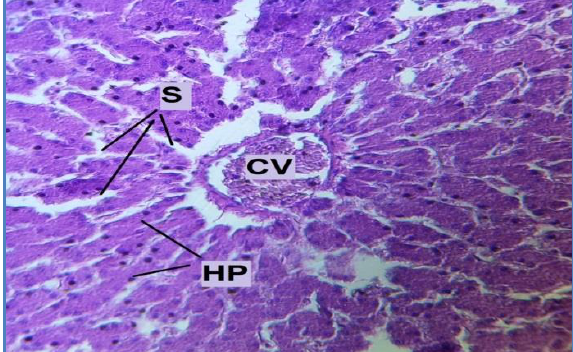
Figure, 7: Histological section of the liver in mallard duck shows, the central vein (CV), hepatocyte plates (HP), sinusoids (S) (H and E 40X).